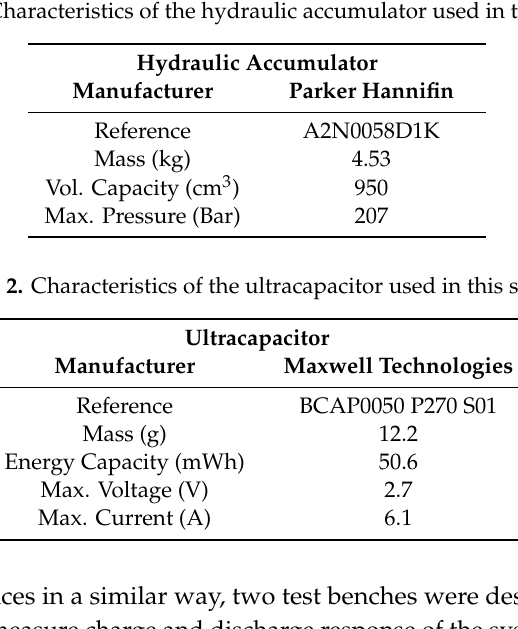
Table 1. Characteristics of the hydraulic accumulator used in this study.